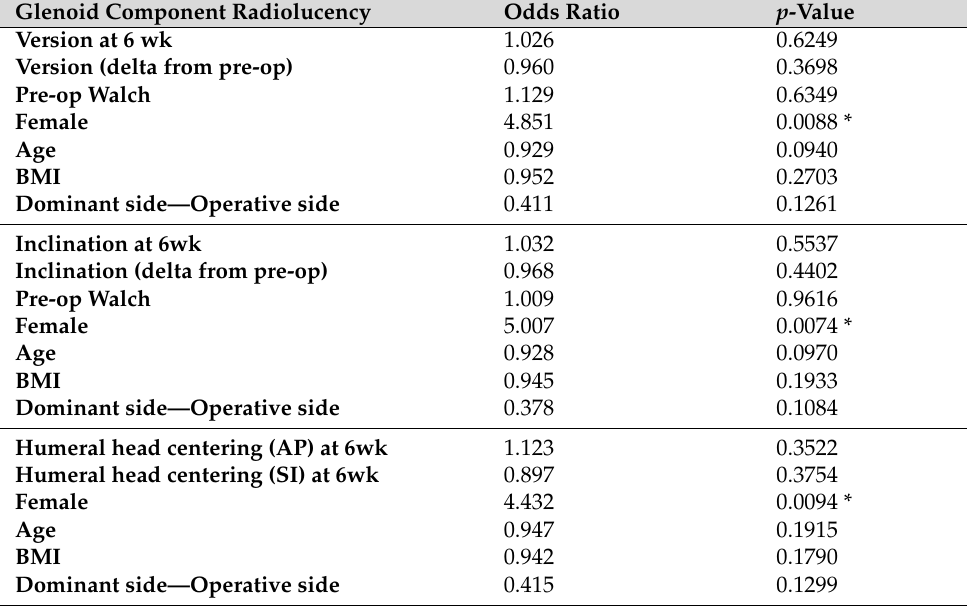
Table 4. Logistic regression models for glenoid component position and glenoid radiolucency.